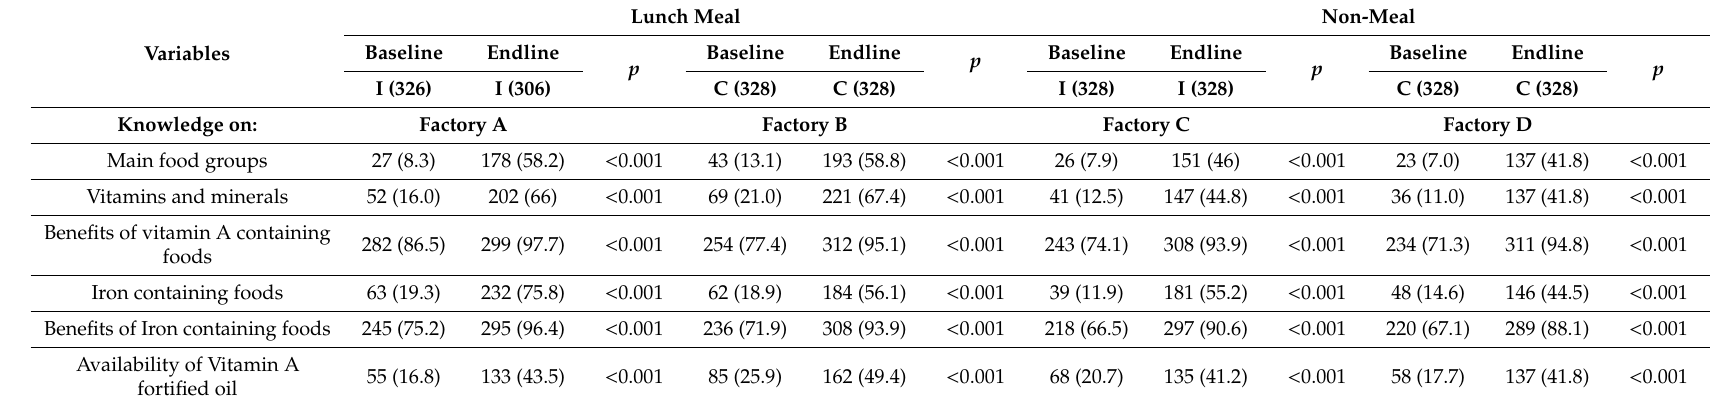
Table 3. Changes in food and nutrition knowledge from baseline to